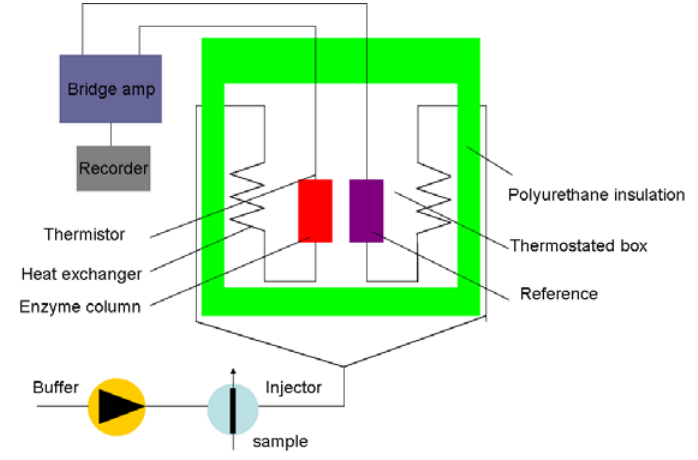
Figure 3. Schematic representation of a thermal biosensor (adapted from [36]).